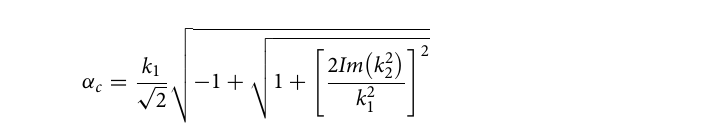
Figure 2. ( a ) Menzel Antenna design principle, cross-section view, the top metal layer (microstrip) has a width of W, and a thin dielectric substrate of height h, whose relative permittivity is ε r > 1 , separates it from the ground plane. ( b) Longitudinal view: the antenna has length L, and it is fed at z = 0 and closed to a matched load at z = L. In the figure, the radiation due to the first higher-order (EH 1 ) mode is